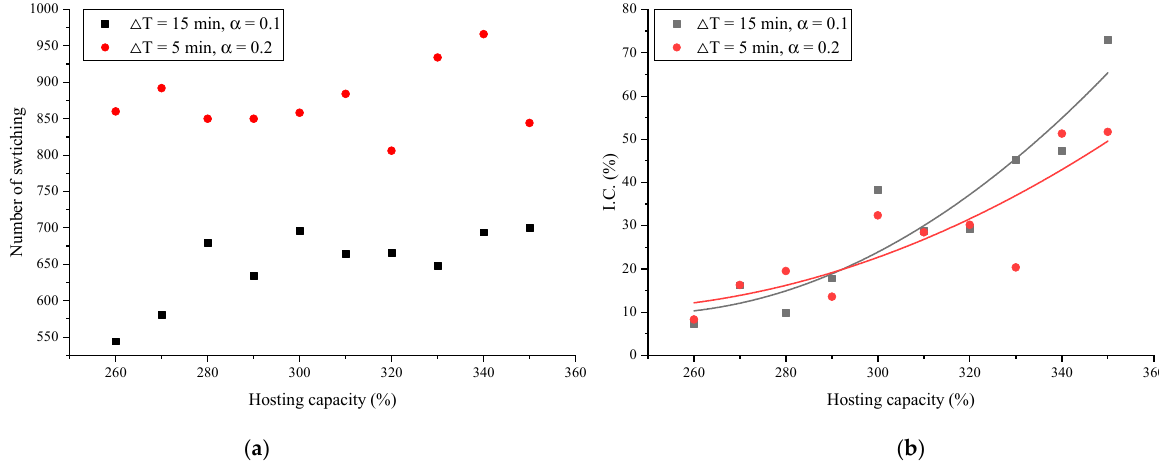
Figure 21. Comparison of the performance indices with respect to HC: ( a ) number of switching operations and (b) incremental curtailment .